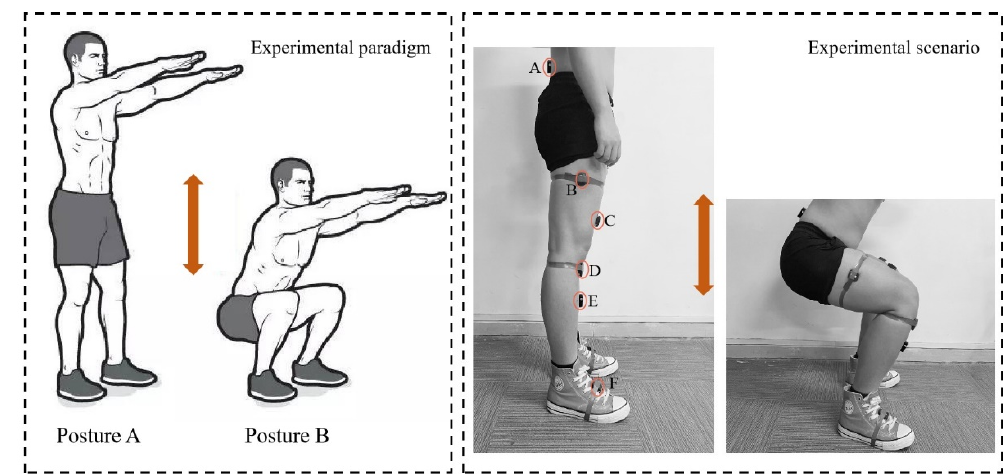
Figure 2. Fixed-length weightless lower-body squat exercise test.